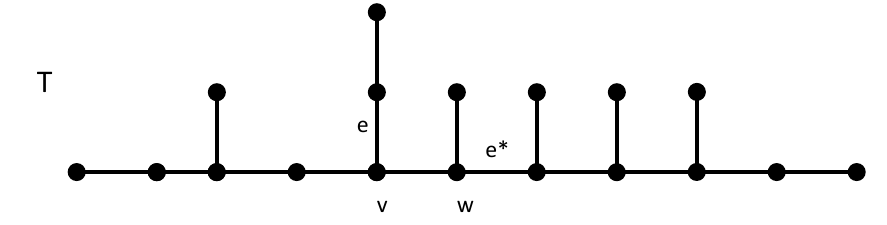
and 𝐶 by adding a new edge 𝑣𝑤 to form a thin 1 2